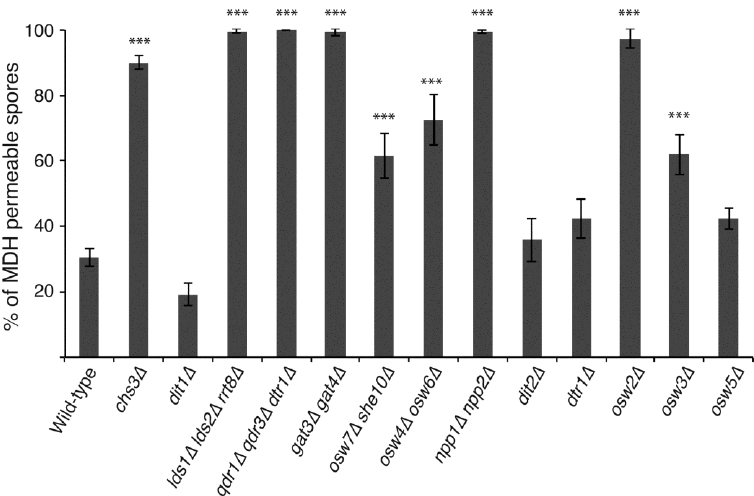
Figure 3. The effects of different outer spore wall mutants on MDH permeability. Wild-type (AN120), chs3 ∆ (AN262), dit1 ∆ (AN264), lds1 ∆ lds2 ∆ rrt8 ∆ (CL6), qdr1 ∆ qdr3 ∆ dtr1 ∆ (CL7), gat3 ∆ gat4 ∆ (CL15), osw7 ∆ she10 (CL26), osw4 ∆ osw6 ∆ (CL35), npp1 ∆ npp2 ∆ (CL57), dit2 ∆ (ySZ233), dtr1 ∆ (MYA-1810), osw2 ∆ (ySZ265), osw3 ∆ (MYA-1824), and osw5 ∆ (MYA-2022) diploids were incubated on SPO plates for eight days and then tested for MDH staining of lipid droplets within the spores. The percentage of spores displaying internal MDH staining is shown. Values are the averages from four experiments with at least 200 spores scored for each strain in each experiment. Error bars indicate one standard deviation. Asterisks denote strains in which permeability is significantly different from the wild-type ( p < 0.001 student’s t